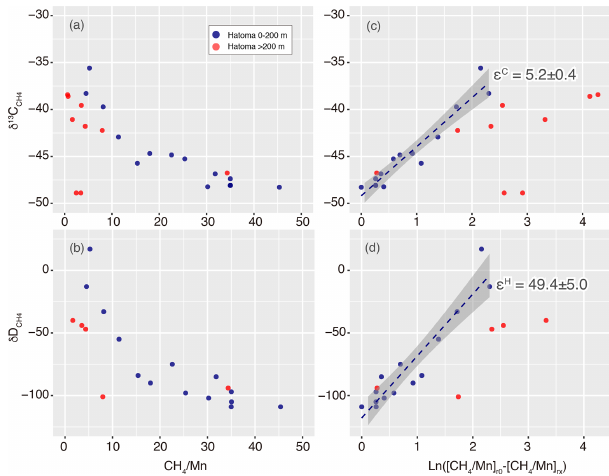
Figure 7. Isotope ratio changes along with aerobic methanotro- phy above Hatoma Knoll. Panels (a) – (b) show CH 4 / Mn ratios while (c) – (d) represent Eq. (5) in the main text. Dashed lines and grey zones illustrated in (c) – (d) represent fitting lines with standard errors corresponding to isotope fractionation factors of the ε C and ε H